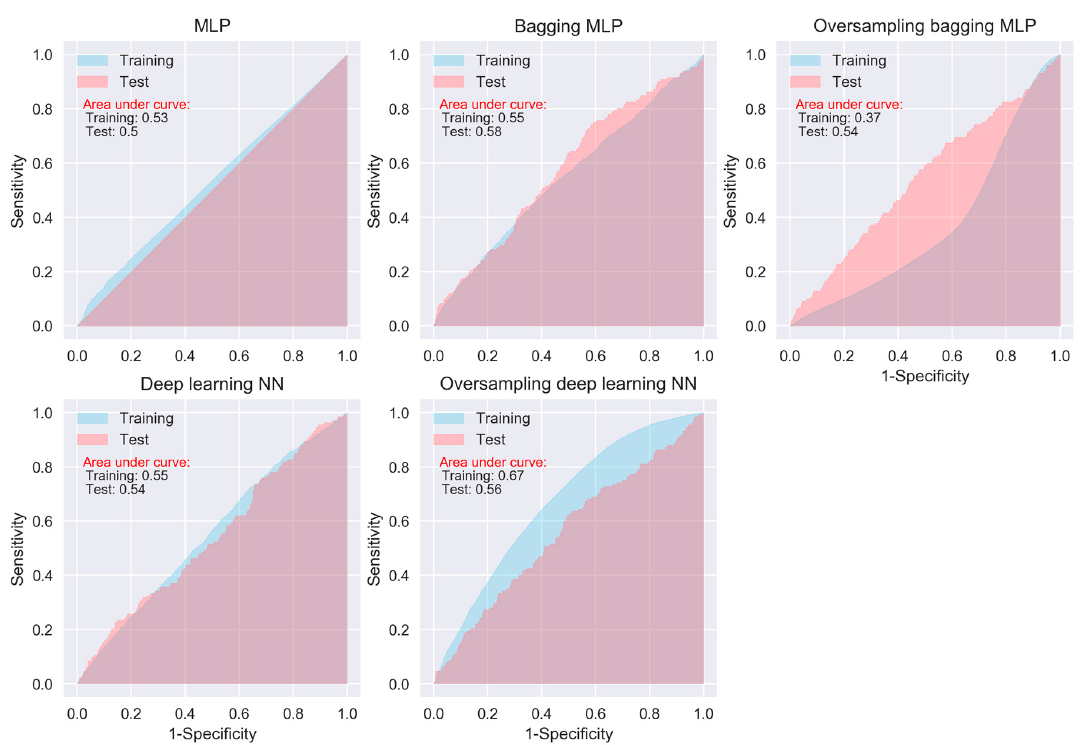
Figure 5. ROC curves of neural network algorithms.